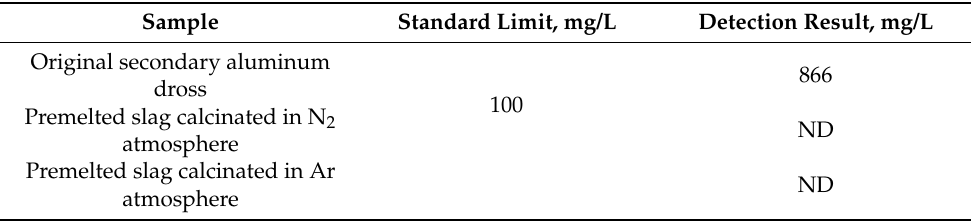
Table 5. Contents of water-soluble fluoride in original secondary aluminum dross and premelted